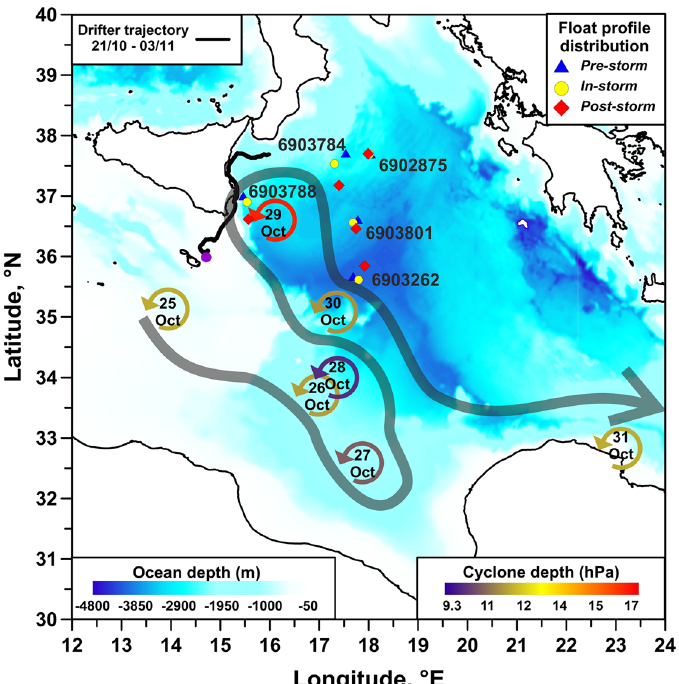
Figure 1. Argo float positions (colored symbols and identification numbers) and track of the drifter IMEI 300234067977120 (black line) superimposed on the geography and bathymetry of the Ionian Sea (sea bottom depth in blue shade). Circular arrows indicate the daily position of the Medicane Apollo from 25 October 2021 12:00 UTC to 31 October 2021 12.00 UTC; arrows are colored by cyclone depth. The gray shaded large arrow gives a schematic view of the path carried out by the Medicane